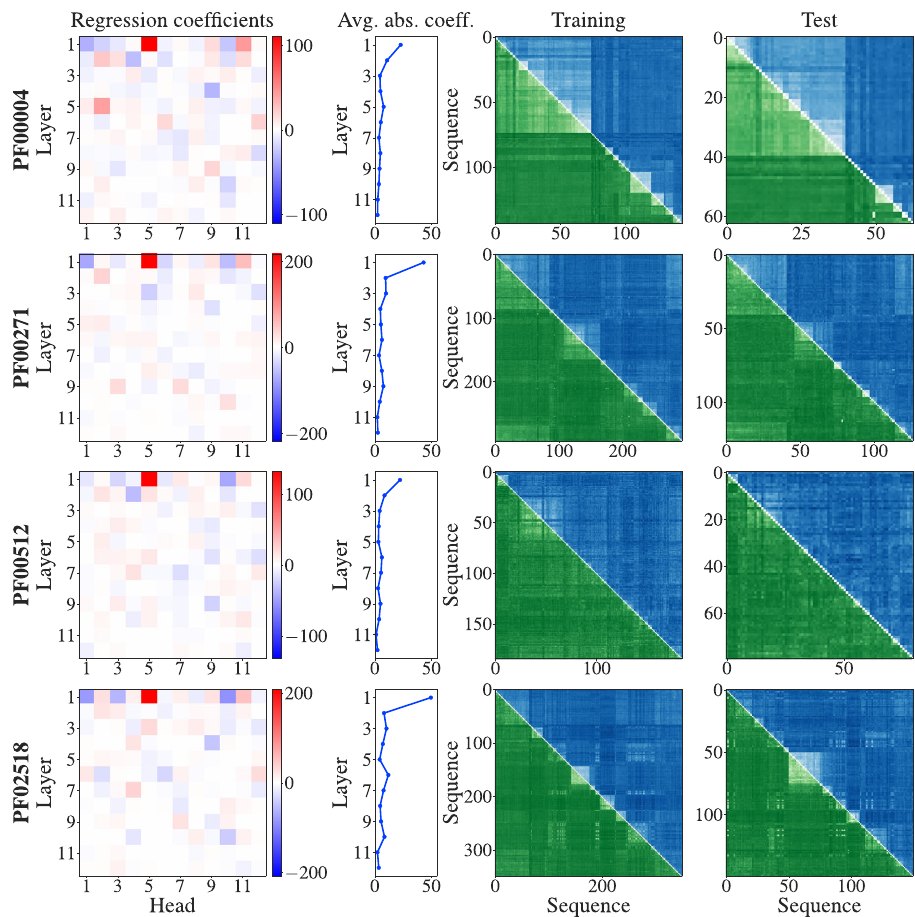
Fig.2|FittinglogisticmodelstopredictHammingdistancesseparatelyineach MSA. The column-wise means of MSA Transformer ’ s column attention heads are usedtopredictnormalisedHammingdistancesasprobabilitiesinalogisticmodel. EachMSAisrandomlysplitintoatrainingsetcomprising70%ofitssequencesand atest set composedof the remaining sequences. ForeachMSA, alogisticmodelis trained on all pairwise distances in the training set. Regression coef fi cients are